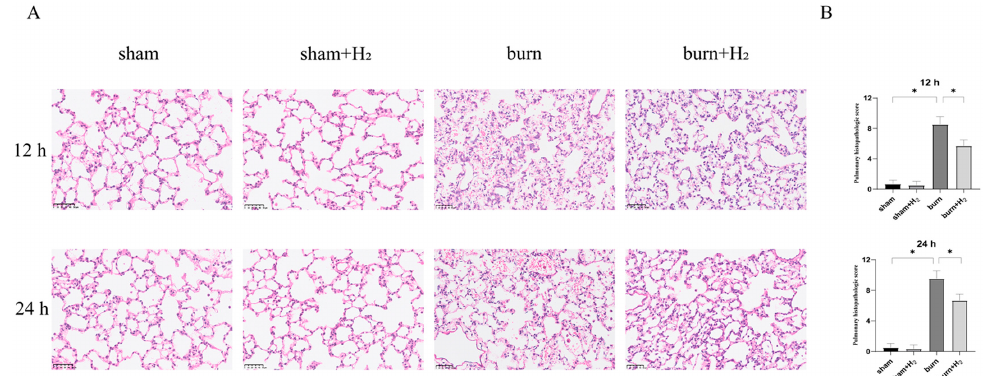
Figure 2. Effects of burns and hydrogen on pulmonary histopathology. Rats were sacrificed 12 h and 24 h after sham or burn operation, and lung tissues were harvested for HE staining ( A ). Lung injury was scored by visualizing the morphological structure ( B ) ( n = 6 rats per group). * p < 0.05. 3.3. Hydrogen Attenuates Burn-Induced Changes in the Expression of NLRP3 and Caspase-1 Total protein was extracted 12 and 24 h after modeling, and the expression levels of NLRP3 and caspase-1 were detected by Western blot analysis. The protein expression of NLRP3 and caspase-1 increased significantly at 12 and 24 h after the burn and showed an increasing trend. These results suggest that NLRP3 and its downstream protein caspase- 1 may be involved in the pathogenesis of ALI post-burn. Hydrogen treatment partially reversed the increase in the expression of the above proteins ( p < 0.05). There was no sig- nificant difference between the sham and sham + H 2 groups ( p > 0.05) (Figure 3). Figure 3. Hydrogen attenuates burn-induced changes in the expression of NLRP3 , caspase-1 and GSDMD at 12 ( A ) and 24 h ( C ) after the burn. The expression levels of NLRP3, caspase-1 and GSDMD were detected by Western blot analysis. Quantitative analysis of NLRP3, caspase-1 and GSDMD ( B , D ) levels, shown as the ratio of each protein band density to that of β -actin ( n = 6 rats per group). * p < 0.05. 3.4. Hydrogen Reduces Inflammation Caused by Burns To assess the effects of burn and hydrogen treatment on the inflammatory response in rats, we evaluated the levels of IL-1 β and IL-18 in the lung tissue of each group at 12